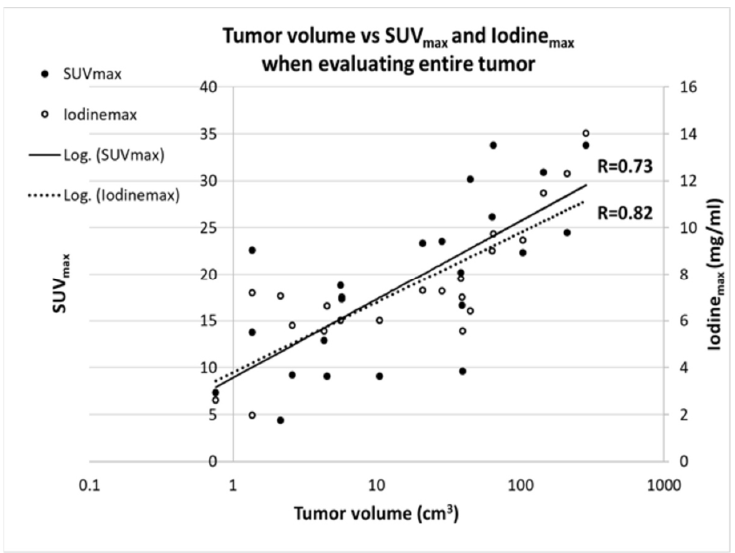
Figure 3. Scatter plot showing the correlation between tumor volume and SUV max and the Iodine max . Tumor volume is depicted on a log scale, because values were not normally distributed. Data were fitted with a logarithmic function. Both logarithmic data fits showed a significant correlation ( p -value SUV max = 0.0001; Iodine max = <0.0001).